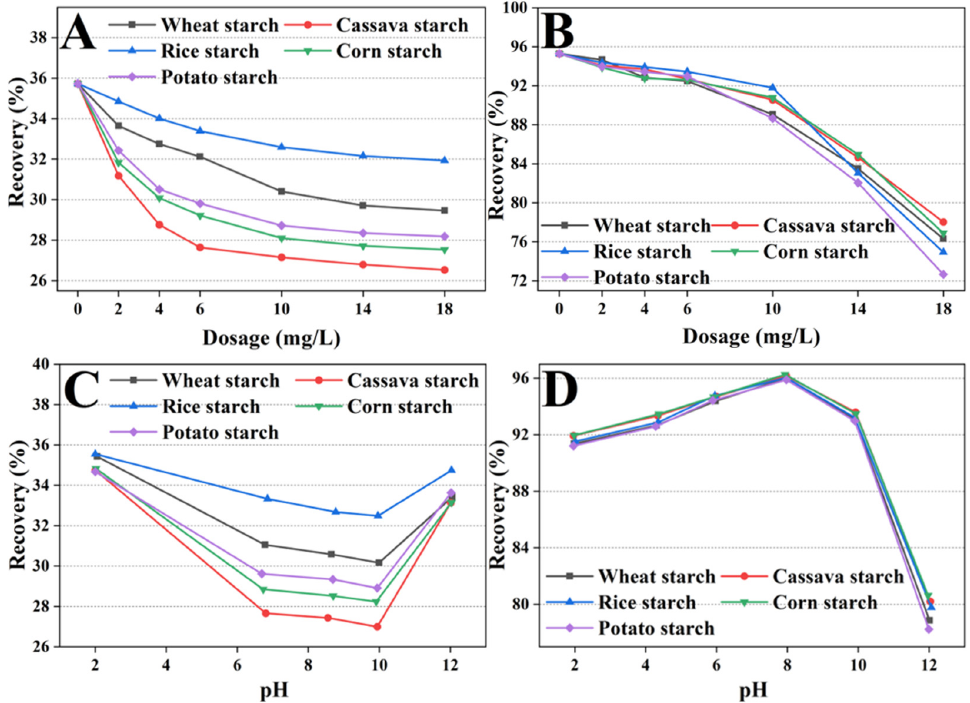
Figure 5. Recovery of serpentine ( A , C ) and pentlandite ( B , D ) as a function of the depressant dosage or the pH value ([PBX] = 1 × 10 –4 mol/L; [MIBC] = 1 × 10 –4 mol/L).